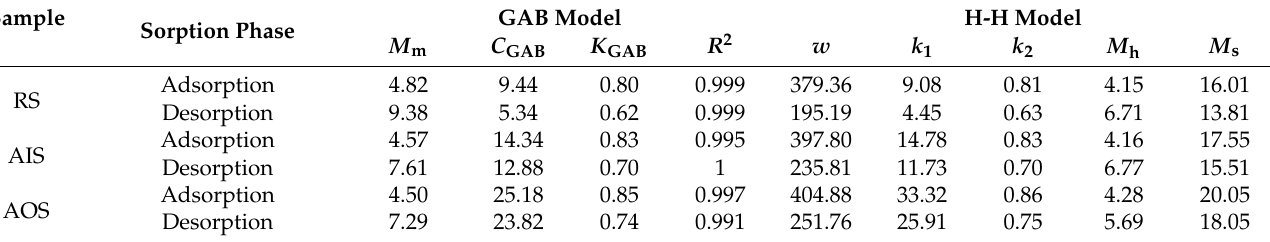
Table 1. Coefficients of the GAB and H-H models for AOS, AIS, and recent wood.